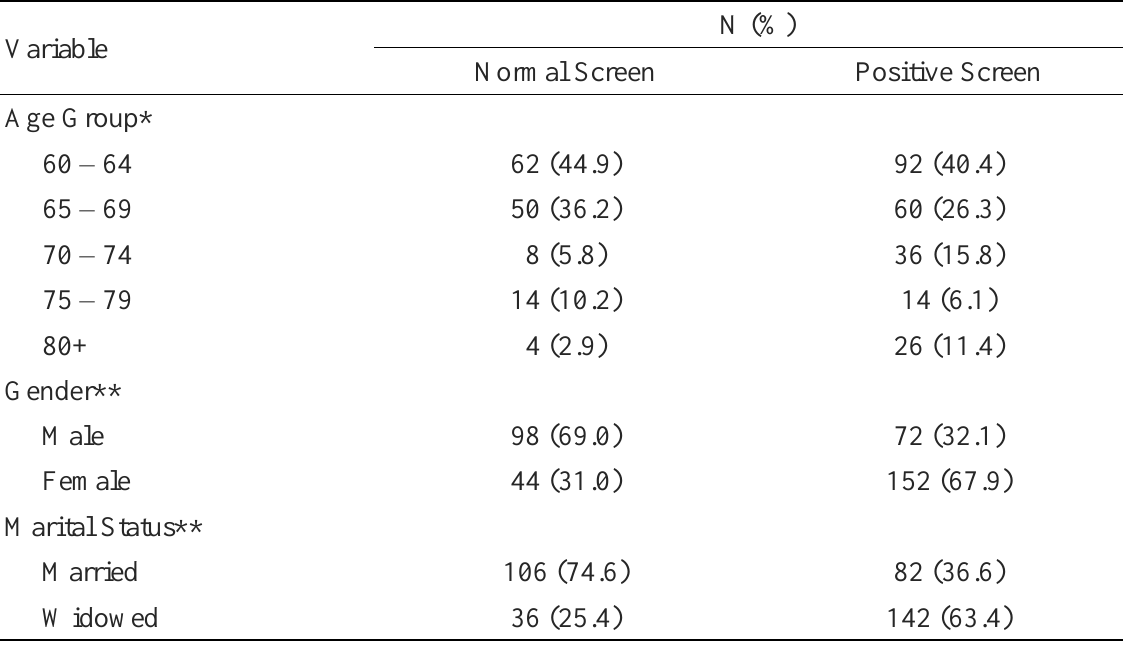
Table 2: Distribution of psychiatric disorder prevalence stratified by age, sex, and marital